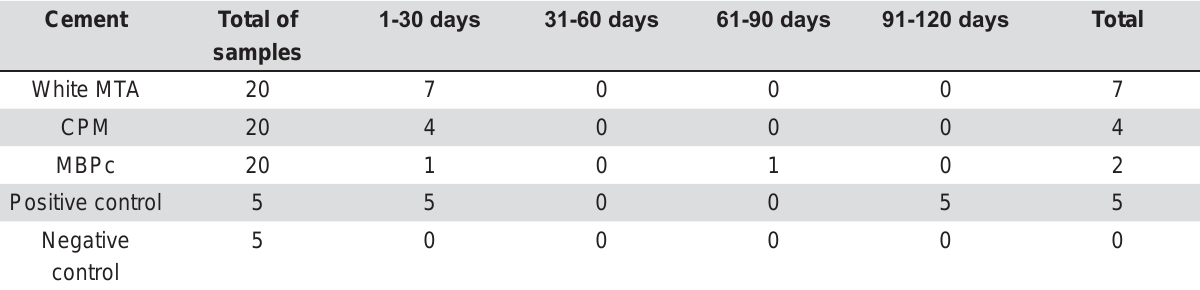
Table 1- Number of samples with positive bacterial leakage every 30 days